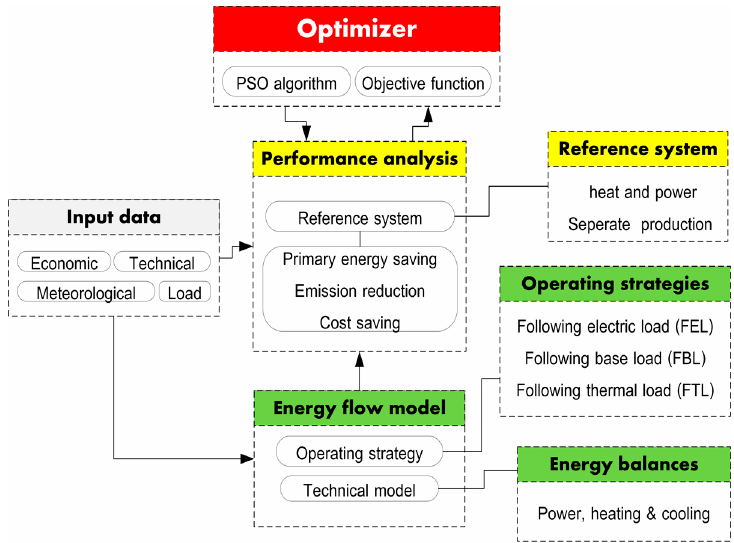
Figure 3. Flowchart of the optimization model.